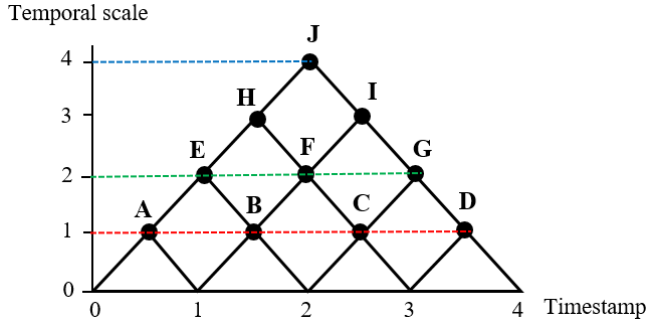
Figure 12. Illustration of the local level (red dotted line), interval level (green dotted line), episodal level (green dotted line) and global level (blue dotted line) in the CTM.